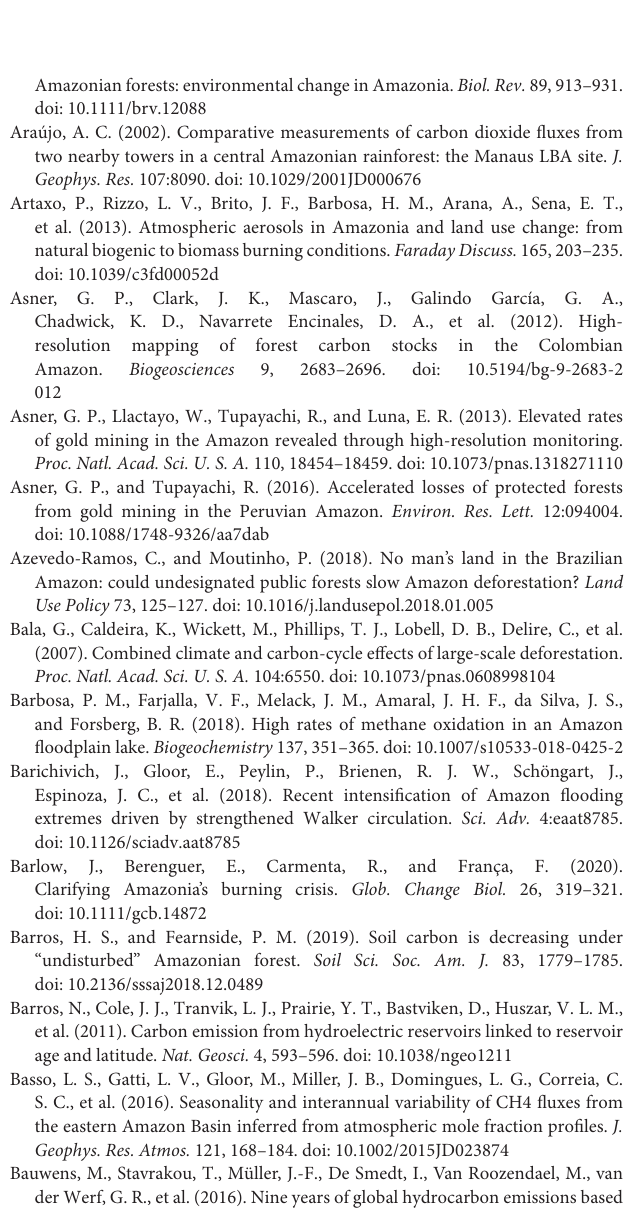
the Amazon basin or elsewhere in tropical ecosystems. These sources were used to derive direction and confidence of changes in forcing agents in response to disturbance reported in Table 2